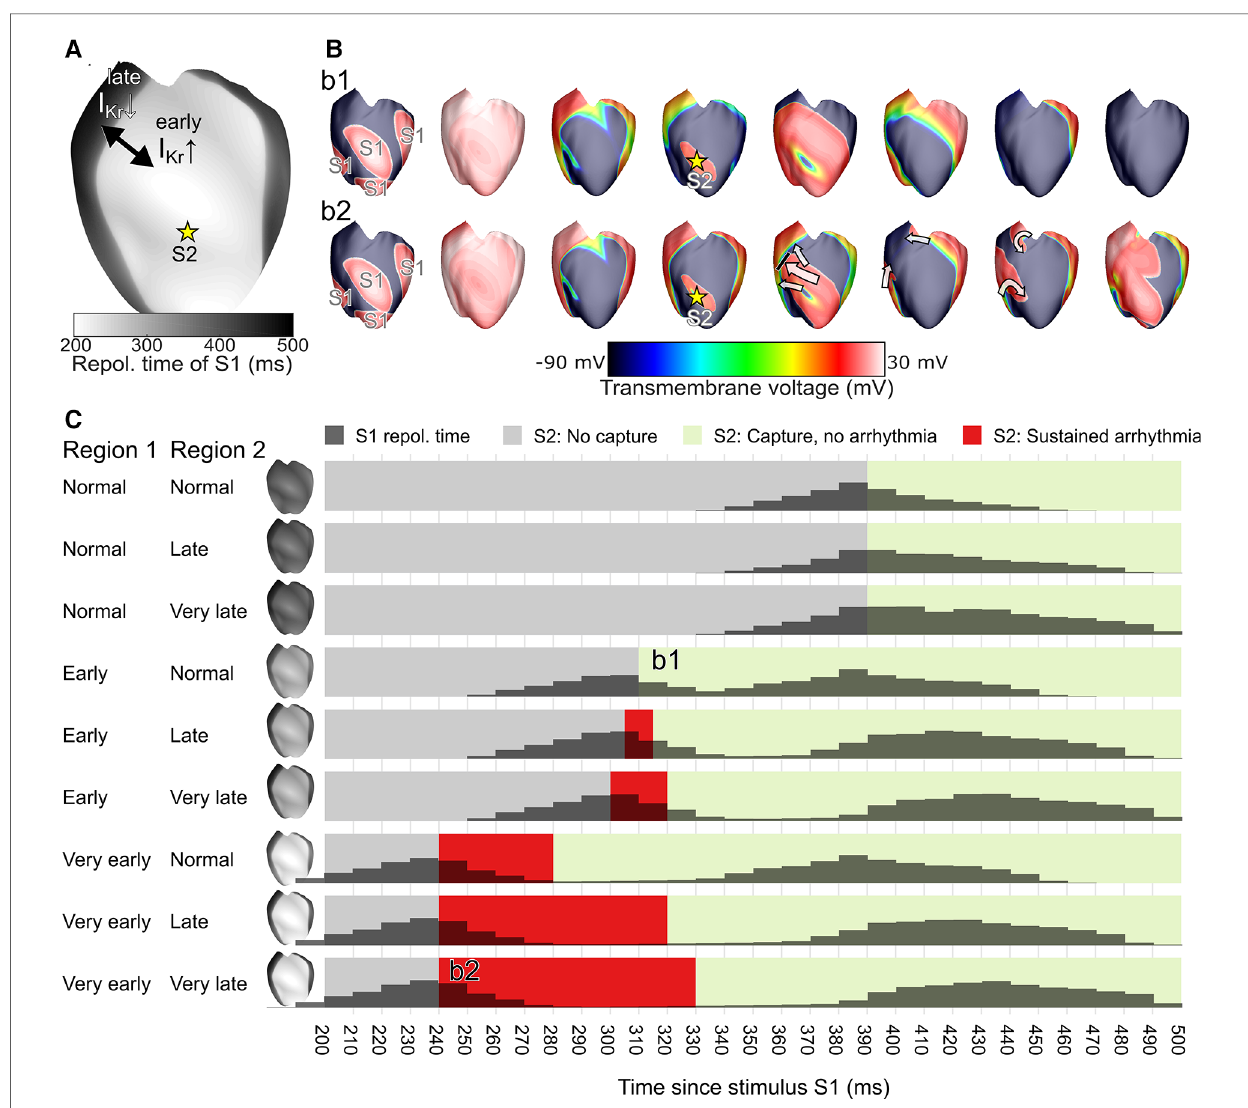
FIGURE 5 In a computational model of ventricular epicardium, a region of early and late repolarization was created by changing the conductance of the rapid delayed-recti fi er potassium current (I Kr ) in an early and late region ( A ). An S1-S2 stimulus protocol was used to test arrhythmia induction for different settings of the early RT region, the late RT region, and the S1-S2 coupling interval; snapshots of two examples are shown in ( B ). Simulation outcomes are displayed in panel ( C ) and show the S1 repolarization time (histograms), and the arrhythmia outcome for each tested 10 ms S1-S2 interval tested, with the S1-S2 interval leading to sustained arrhythmias displayed in red. The example simulation snapshots of panel B are referenced in panel C as b1 and